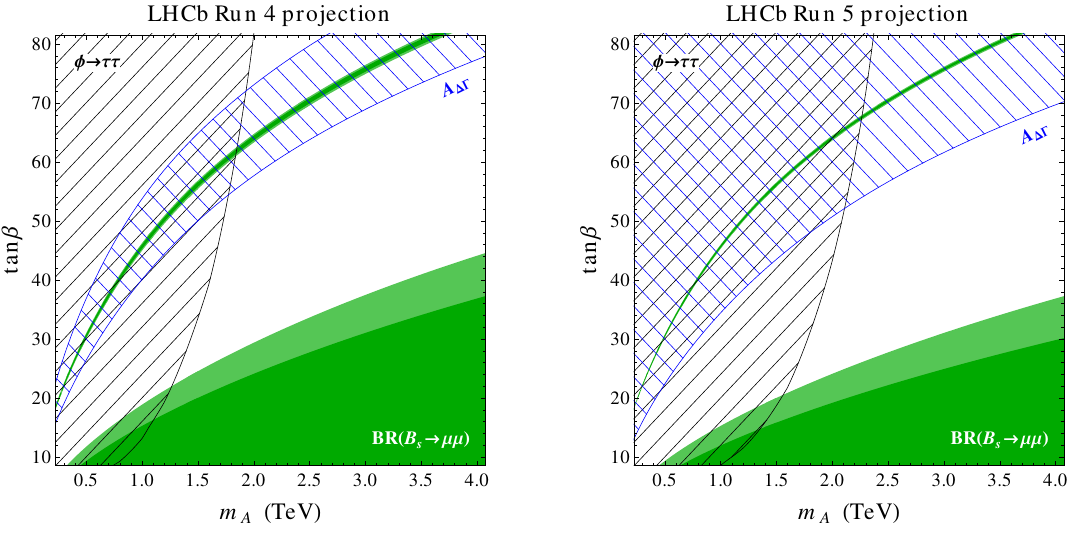
Figure 6 . Expected sensitivities in the m A - tan (cid:12) plane in the MSSM scenario discussed in the text. Left: integrated luminosities of 50 fb (cid:0) 1 at LHCb and 300 fb (cid:0) 1 at CMS and ATLAS. Right: integrated luminosities of 300 fb (cid:0) 1 at LHCb and 3000 fb (cid:0) 1 at CMS and ATLAS. The dark and light green shaded regions will be allowed by the expected BR( B s (cid:22) + (cid:22) (cid:0) ) sensitivity at the 1 (cid:27) and ! 2 (cid:27) level, assuming the SM rate. The black hatched region could be excluded by direct searches for (cid:28) + (cid:28) (cid:0) resonances assuming no non-standard signal. The blue hatched region can be covered by measurements of the mass-eigenstate rate asymmetry A (cid:1)(cid:0) . In both plots the light Higgs mass is m h = 125